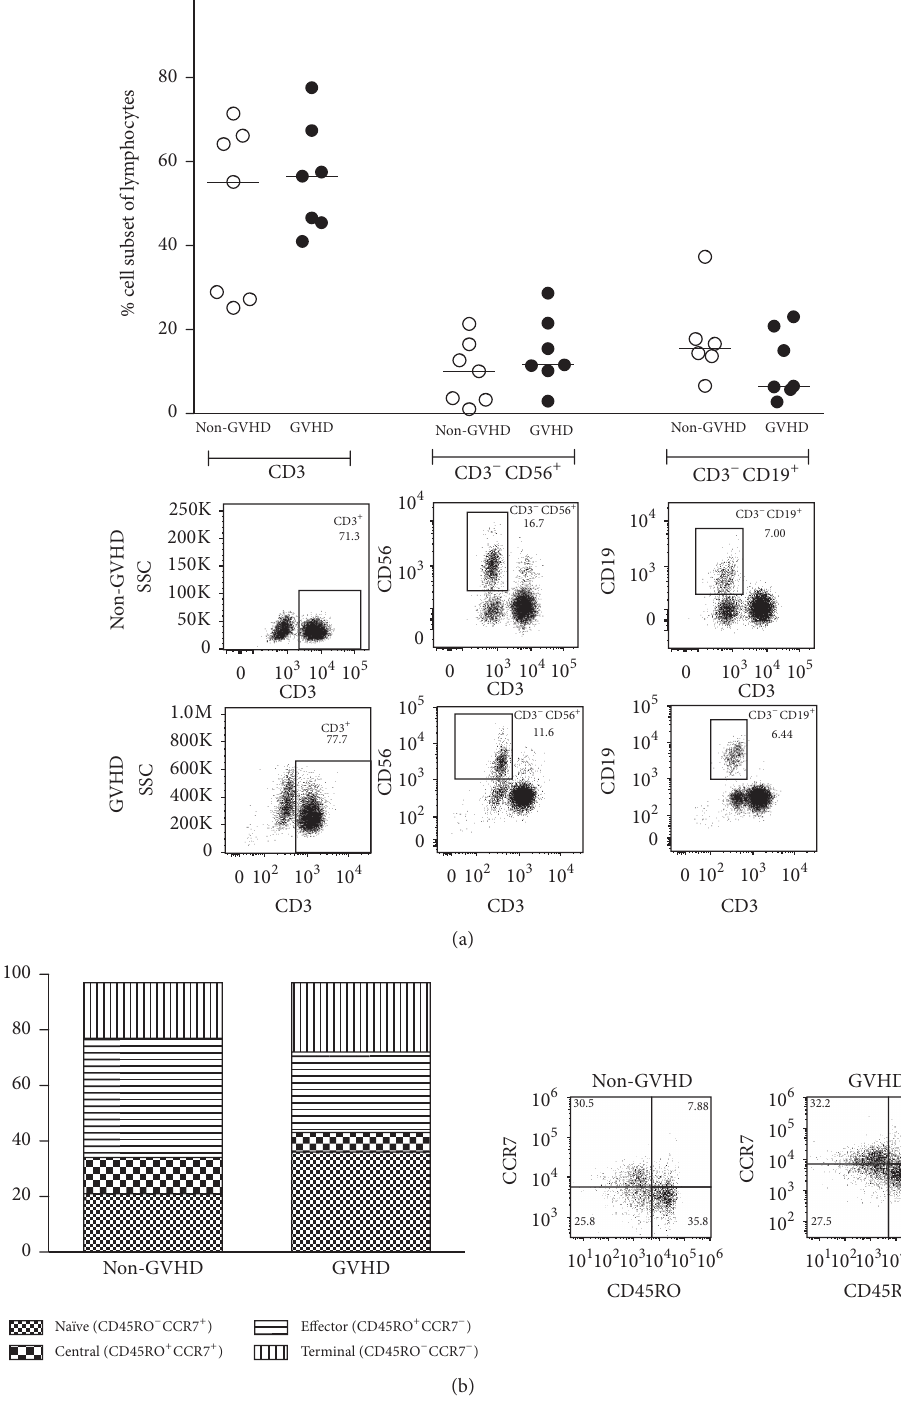
Figure 1: No significant differences between the non-GVHD and GVHD groups regarding major lymphocyte subsets or T-cell maturation subsets in unmanipulated donor samples. Flow cytometry-acquired phenotypic data analysed in blood samples from donors. The data were divided into two groups based on if patients did or did not develop acute GVHD grades II–IV. Each dot represents the cell-subset frequency of one donor and horizontal bars indicate the median of each group. Representative FACS plots are shown below each dot-plot of one non-GVHD and one GVHD patient. (a) Percentages of total T-cells (CD3 + ), NK-cells (CD3 − CD56 + ), and B-cells (CD3 − CD19 + ). No differences were observed for these cellular subsets between the non-GVHD and GVHD patient groups. (b) Proportions of T-cell subsets at different maturation states in the total T-cell population, expressed as median percentages. Terminal, terminally differentiated T-cells (CD45RO − CCR7 − ); effector, effector memory T-cells (CD45RO + CCR7 − ); central, central memory T-cells (CD45RO + CCR7 + ); na¨ıve, na¨ıve T-cells (CD45RO − CCR7 + ). No differences were